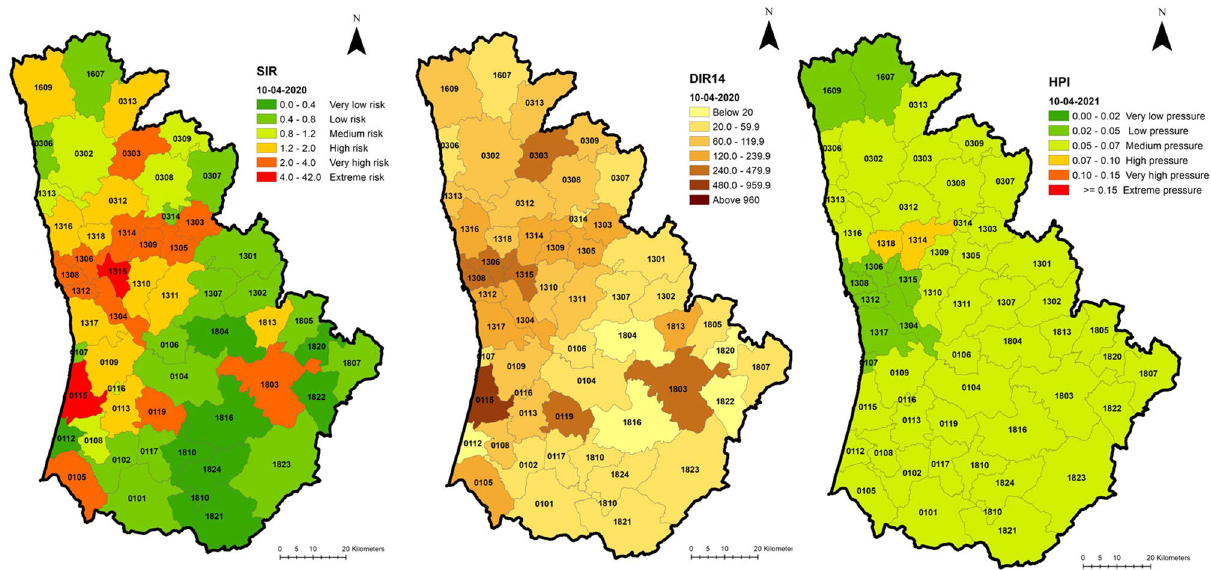
Figure 4. Spatial distribution of SIR, DIR14 and HPI, 10/04/2020, Porto